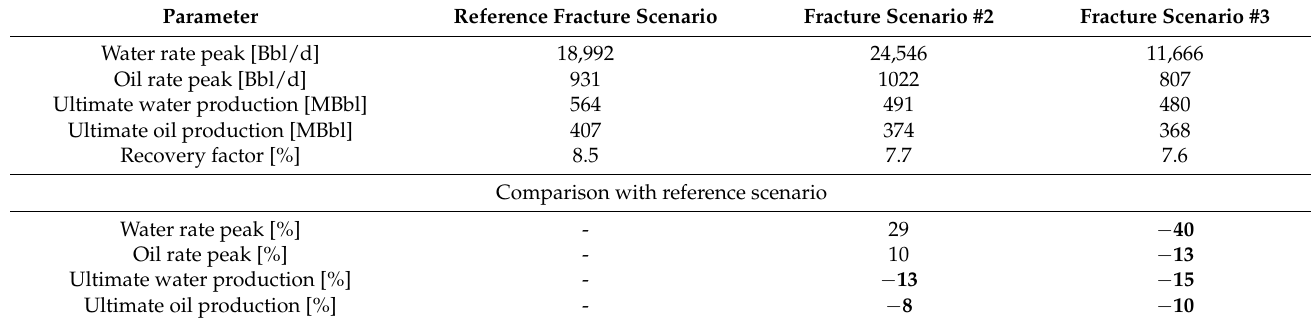
Table 3. Simulation case 1: production comparison after 15 years between fracture scenarios #2 and #3, and the reference scenario #1. The reference fracture scenario comprises 3 vertical hydraulic fractures (HF), fracture scenario #2 has 3 vertical hydraulic fractures and 8 orthogonal natural fractures (NF), and fracture scenario #3 has 3 vertical hydraulic fractures and 2 horizontal bedding planes (BP). The permeability of vertical hydraulic fractures is assumed to be the same (2000 mD) in all three scenarios.